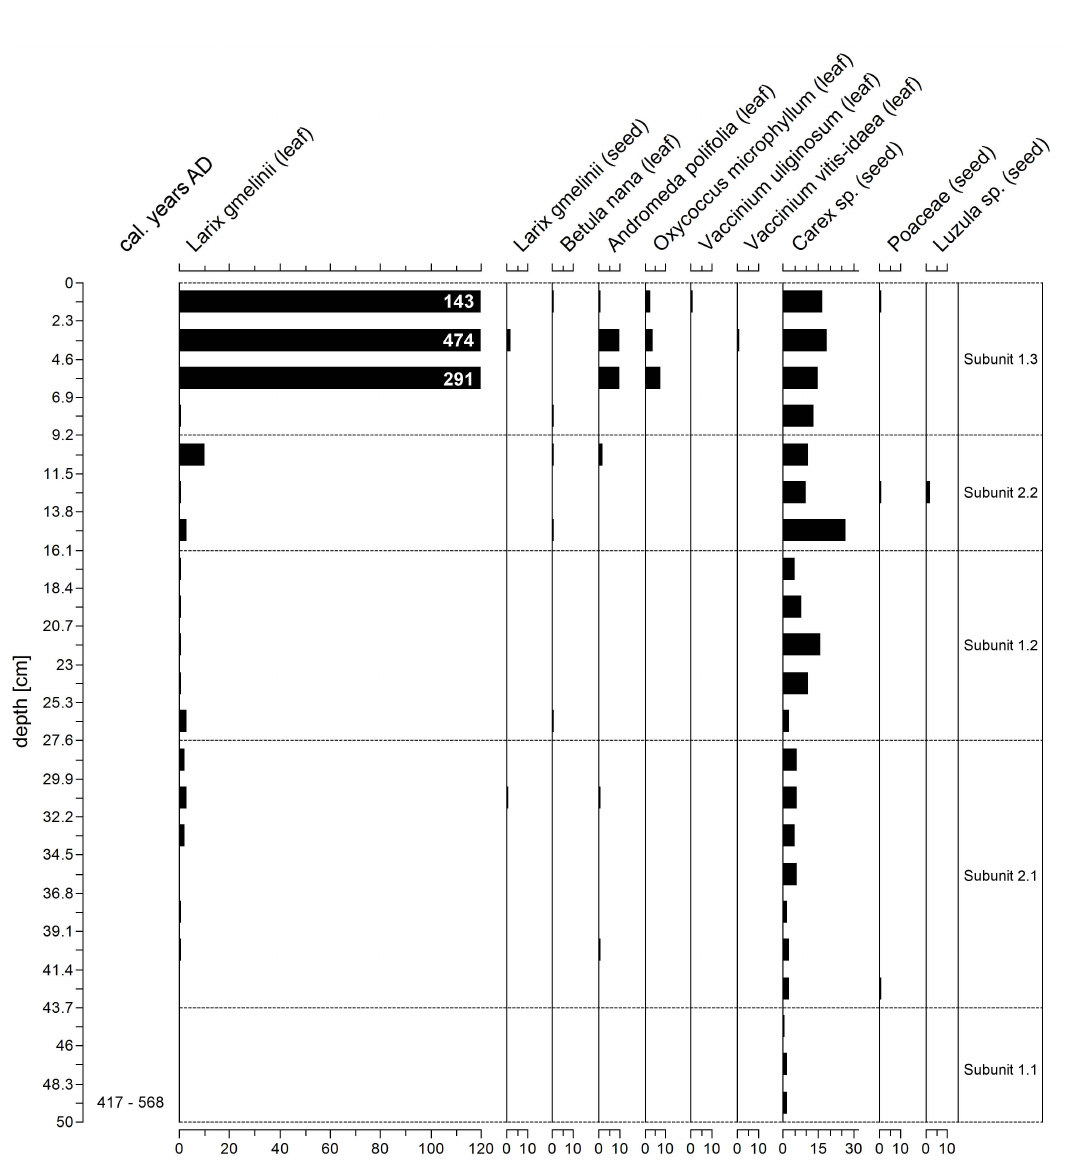
Fig. A6. The macrofossil spectrum for Section B. The peak of Larix leaves in the uppermost samples is due to the presence of trees in the vicinity of the Section B sampling location (see Fig.